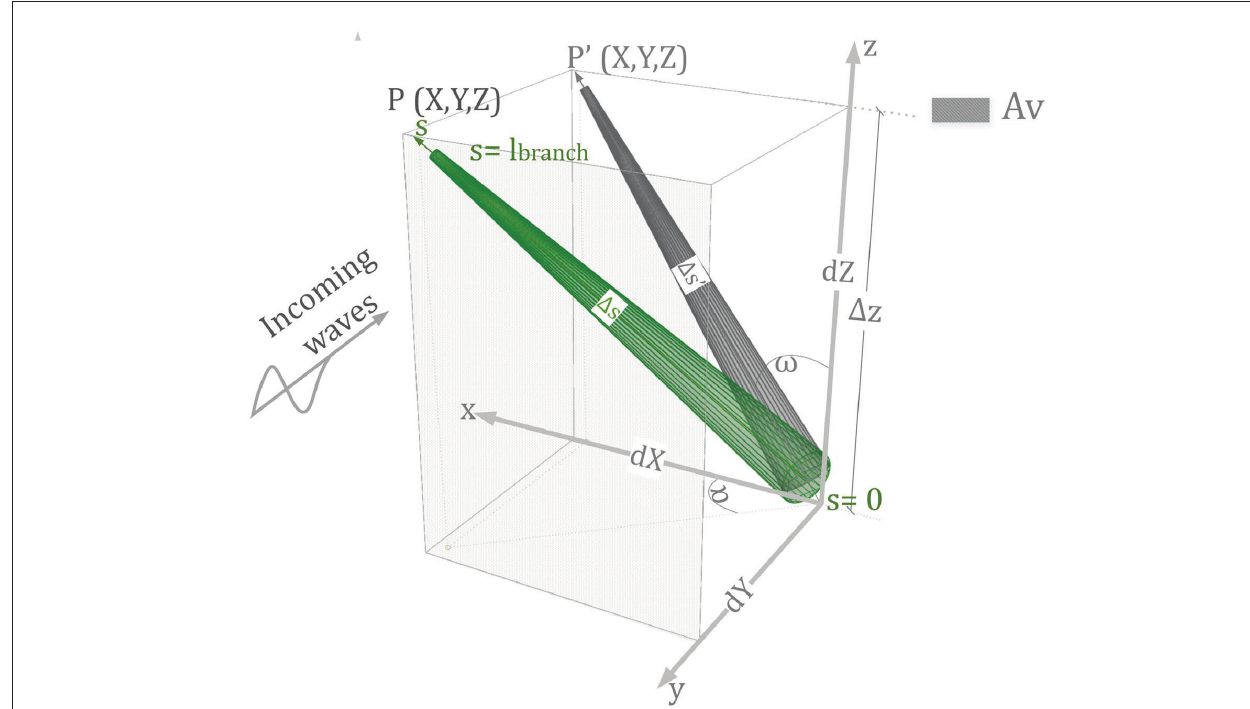
Frontiers in Marine Science |